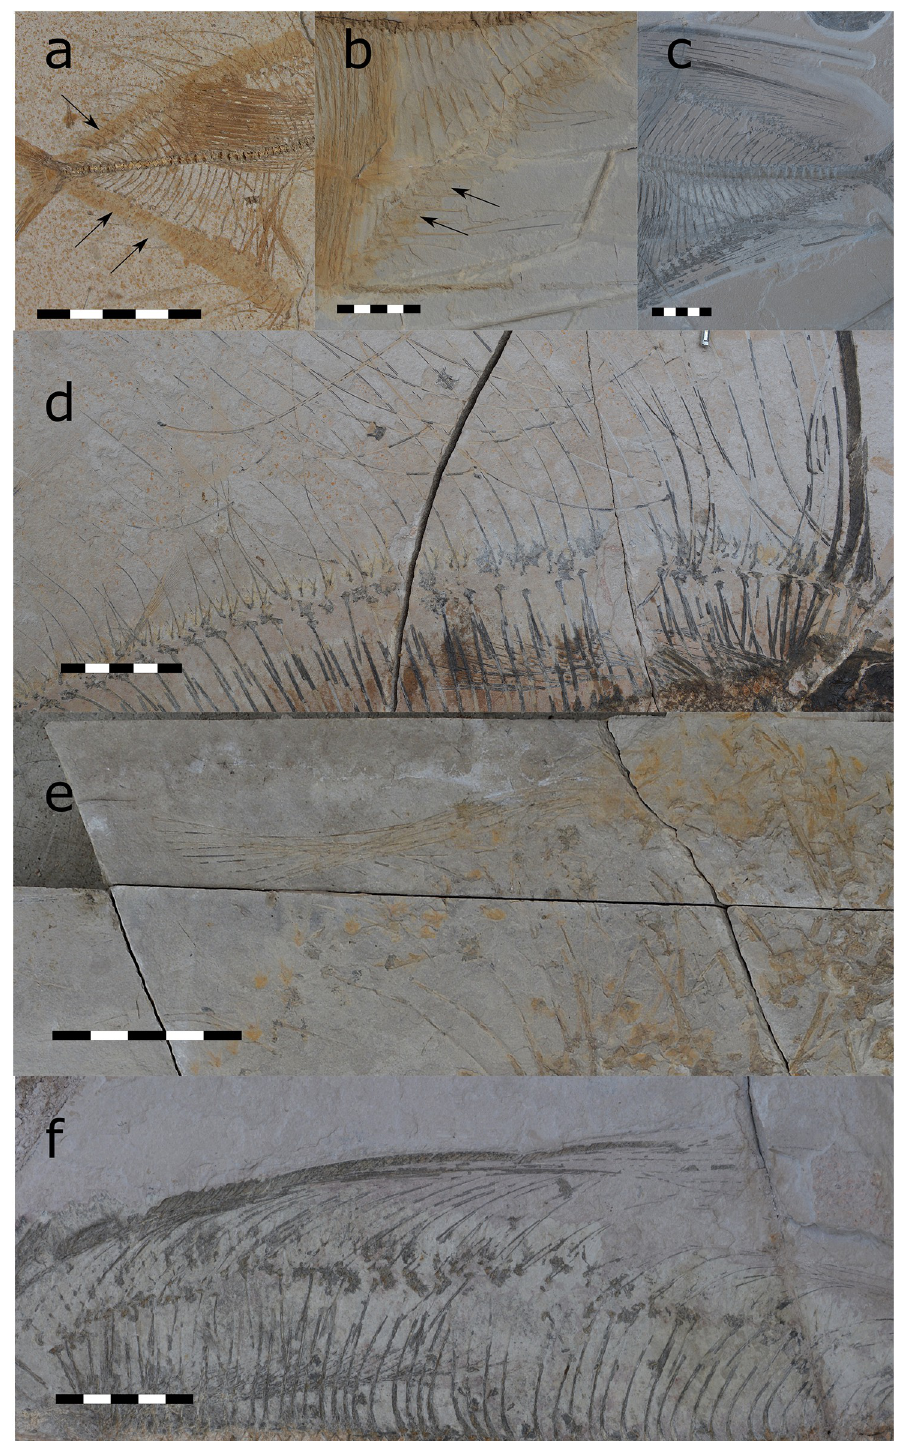
Fig 15. Preservation of the unpaired fins in T . formosa . A skin shadow (CPC-2832 and CPC-2883) (A and B) illustrates the sulcus to retract the dorsal and anal fin. Retracted dorsal fin without overlapping fin rays (CPC-2865) (C). Parallel arrangement of the dorsal fin rays (CPC-2960; REG2544 PF220) (D). Collective reaction of the fin rays similar to a fan indicating an intact membrane between the lepidotrichia (CPC-2902 and CPC-2871) (E and F). All scales 50